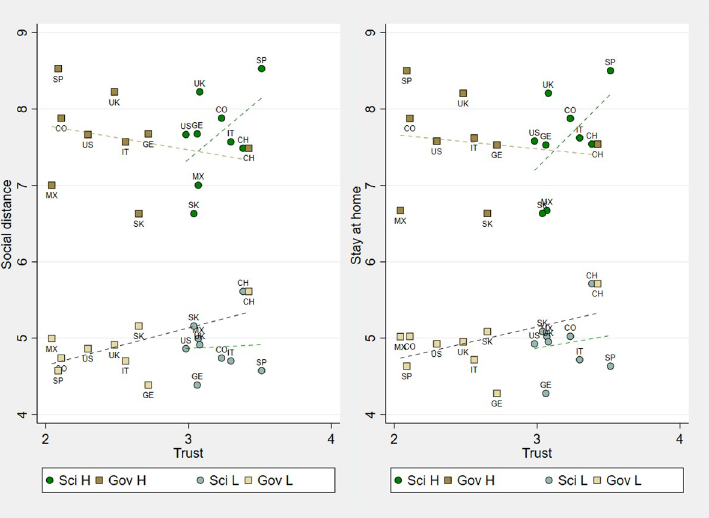
Fig 4. Country level compliance likelihood and trust in science and government. Compliance likelihood at the country level (mean) for High (H) and Low (L) expectations (as in treatments High-High and Low-Low, respectively) and Trust in Science and Government using the 1–4